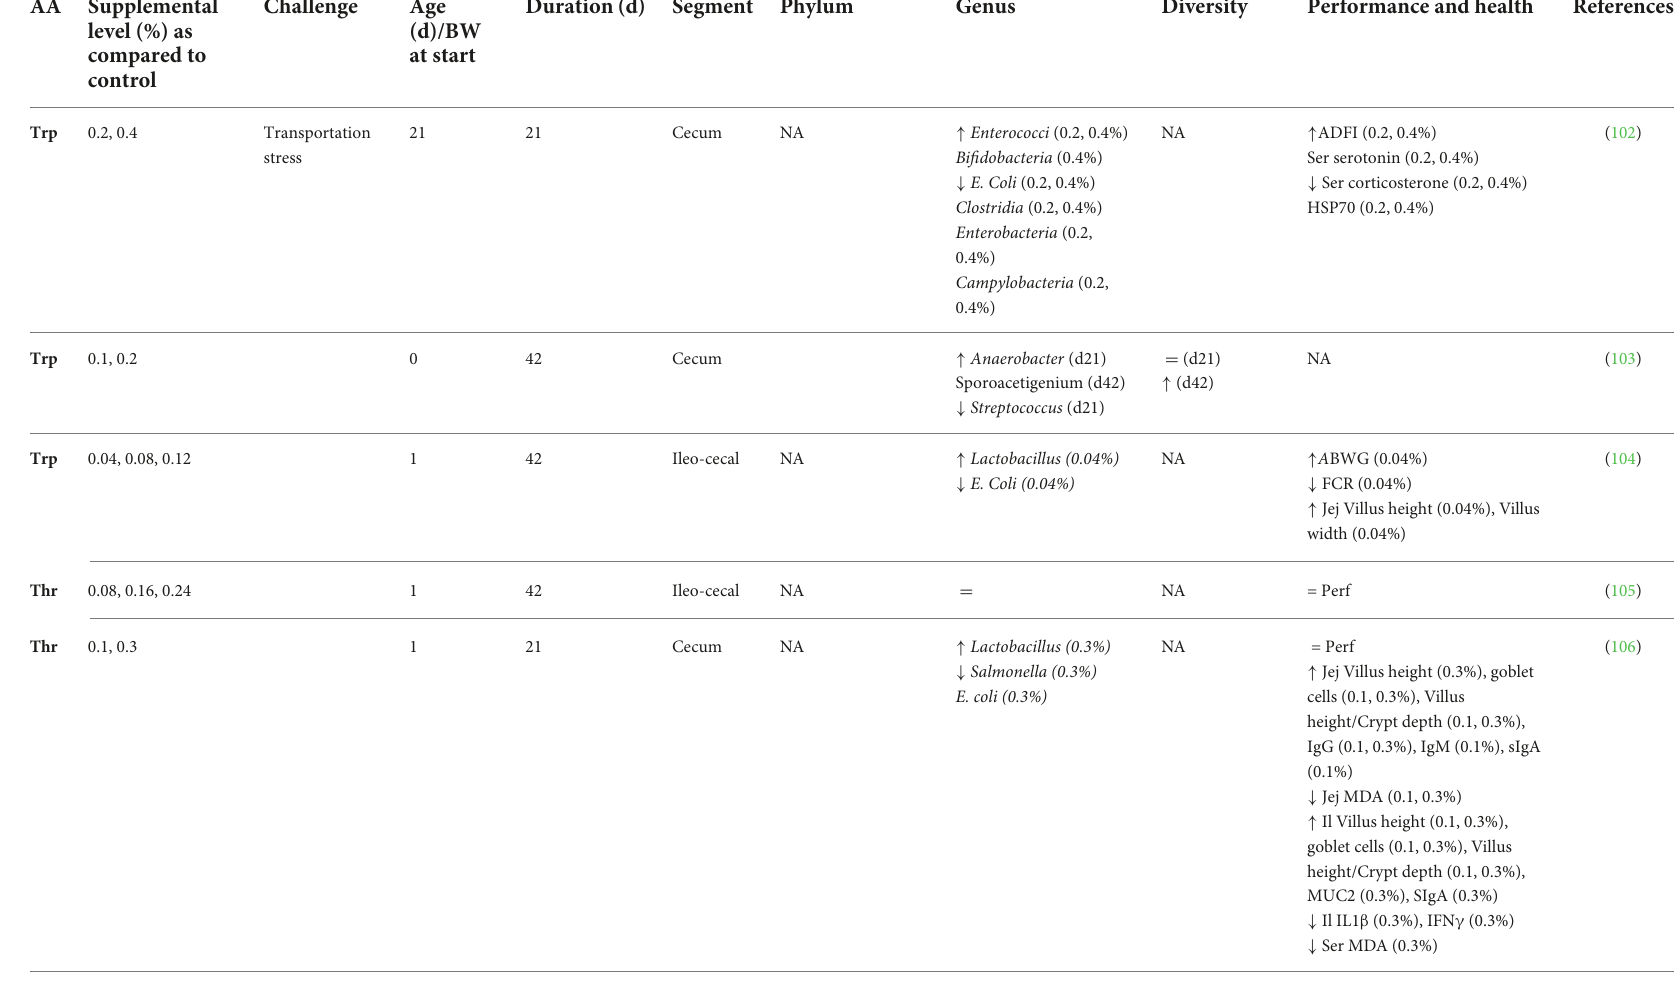
TABLE 4 Effect of free amino acid supplementation on microbiota, performance and health outcomes in